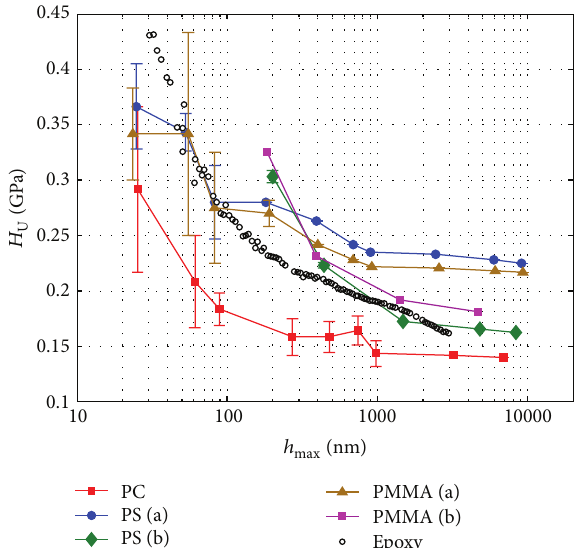
Figure 4: Indentation hardness of epoxy with 20 phr from [25] (with 20 s loading, holding, and unloading times) and [23] (with a constant loading and unloading rate of 1% of the maximum applied force with a 10 s holding time) obtained by the Oliver and Pharr approach